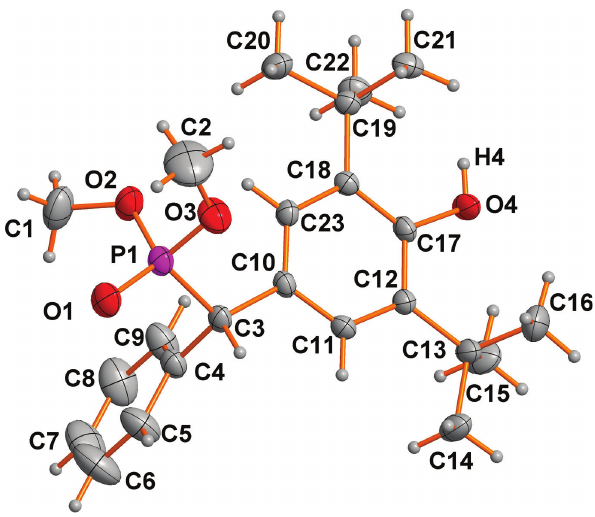
Table 1: Data collection and